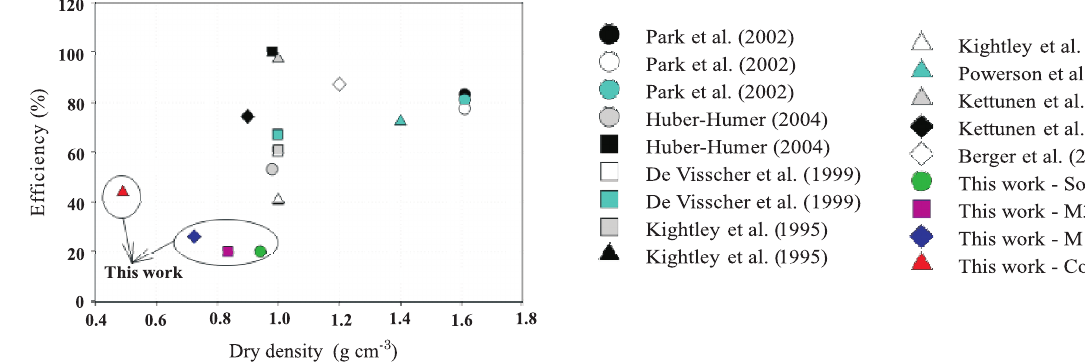
figure 7. Biofilter efficiency versus dry density, as reported in the literature and this study.